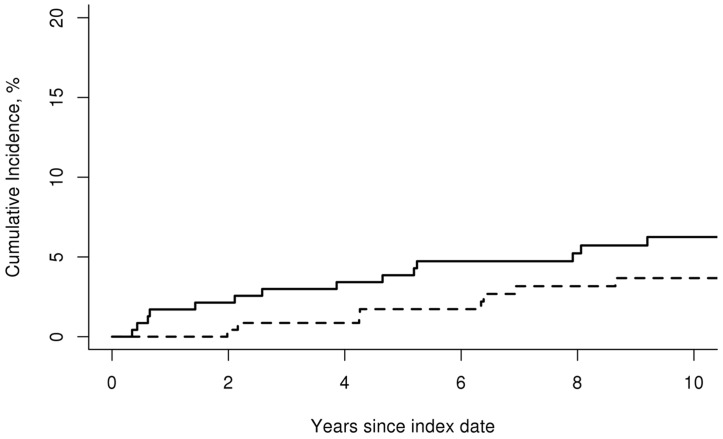
Cumulative incidence of venous thromboembolic events.Cumulative incidence (%) of venous thromboembolism in 244 patients with incident GCA in the period 1950–2009 (solid line) compared to 240 subjects without GCA (dashed line).